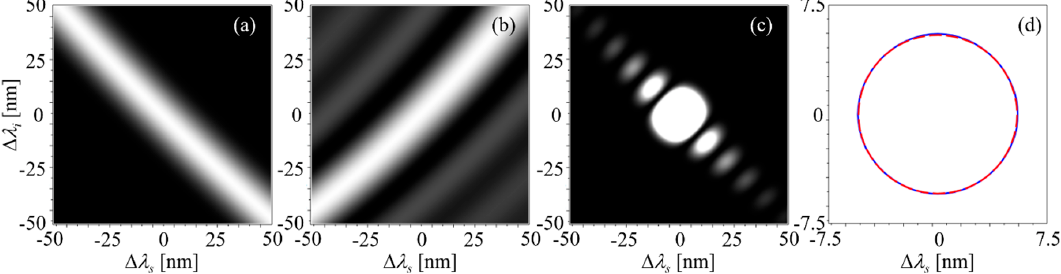
Figure 6. Type II SPDC in a non-poled KTP with the maximum d eff (Table 1) ( a ) pump envelope (PE) function, ( b ) PM function, ( c ) joint spectral intensity (JSI), and ( d ) the contour line for JSI = 0.5 (blue solid line) shown with a circle with a diameter of 11 nm (red dashed line). The calculated purity is 0.996.